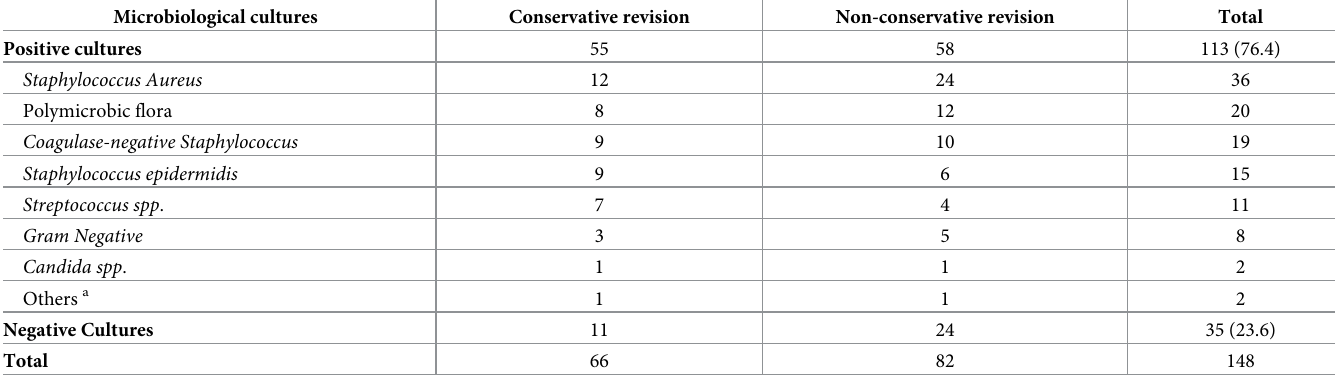
Table 1. Microbiological